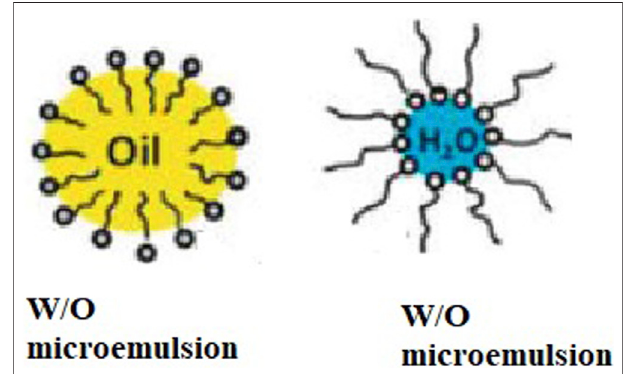
FIGURE 2 | Representation of different types of